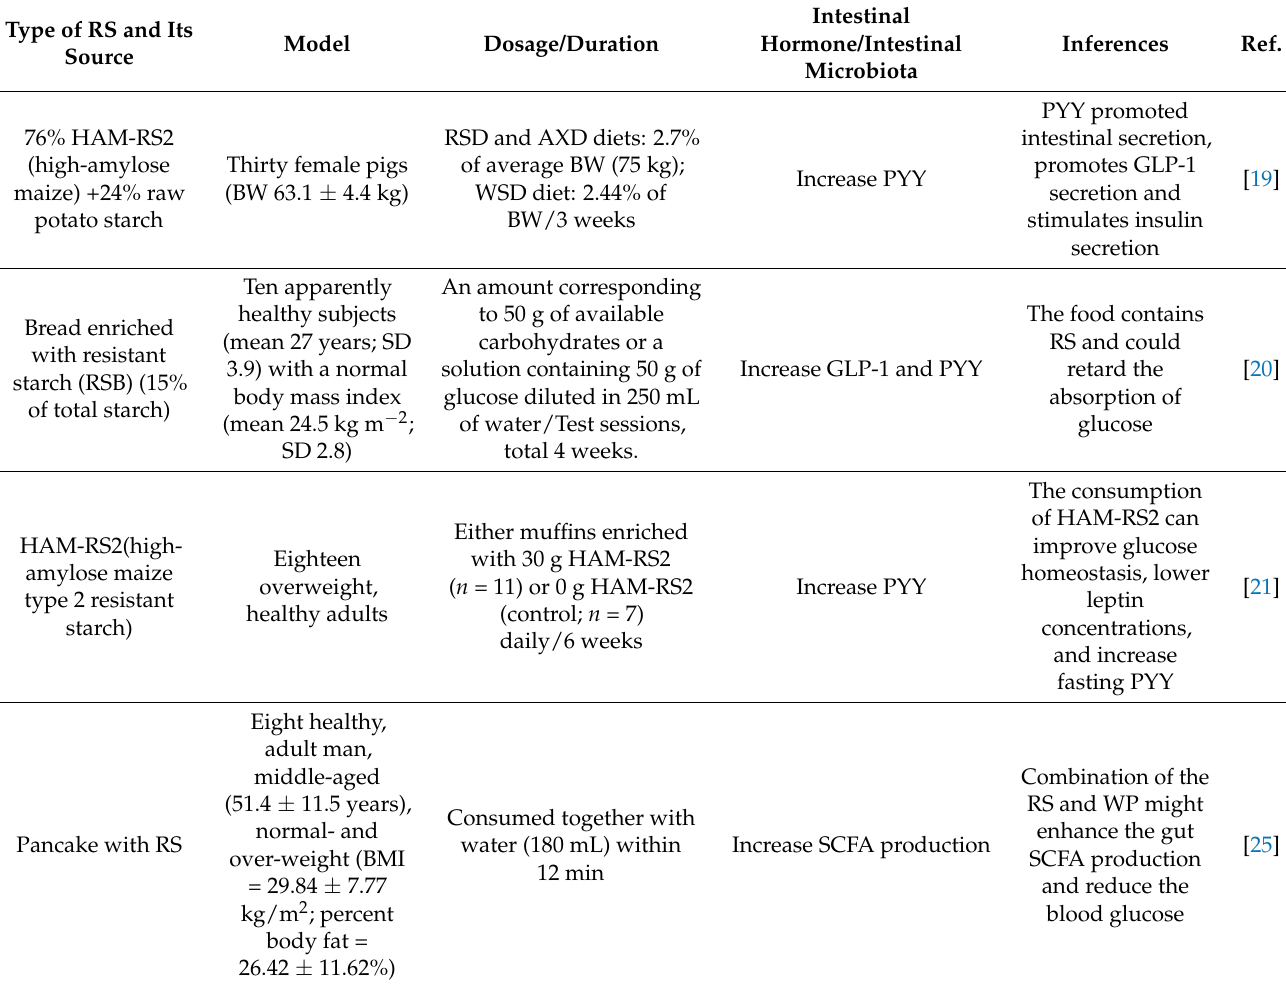
Table 1. The reported mechanisms of regulating the intestinal microbiota